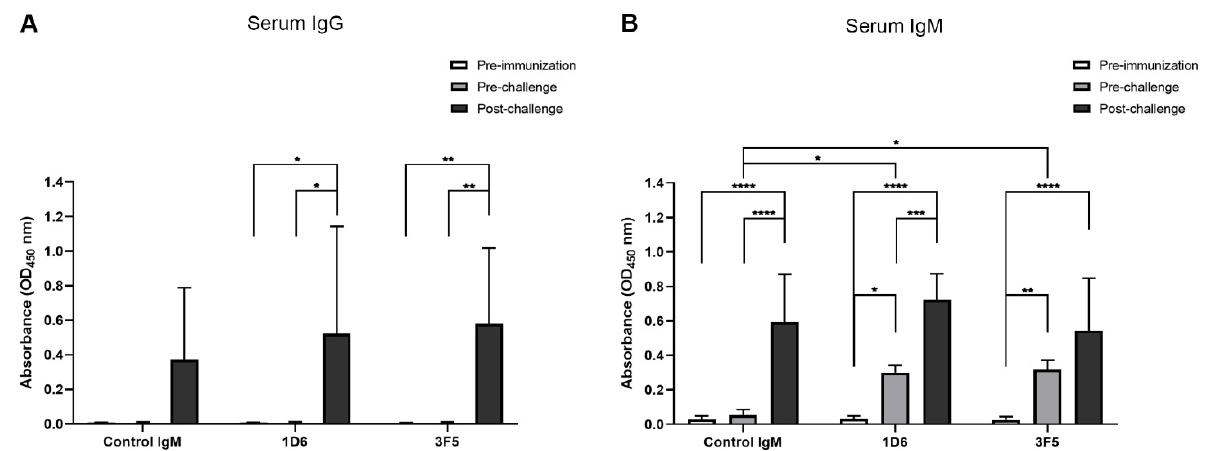
Figure 3. Anti- Ov -TSP-2 serum IgG and IgM levels in passively immunized hamsters determined by ELISA at pre- immunization (day -1), post-immunization/pre-challenge (day 0), and post-challenge at necropsy (week 8 post-infection). ( A ) Serum IgG and ( B ) serum IgM against recombinant Ov -TSP-2-LEL was measured from hamsters that were passively immunized with 1D6, 3F5, and the IgM isotype control. Results represent the mean absorbance at 450 nm for each group. * p < 0.05, ** p < 0.01, *** p < 0.001, and **** p < 0.0001.